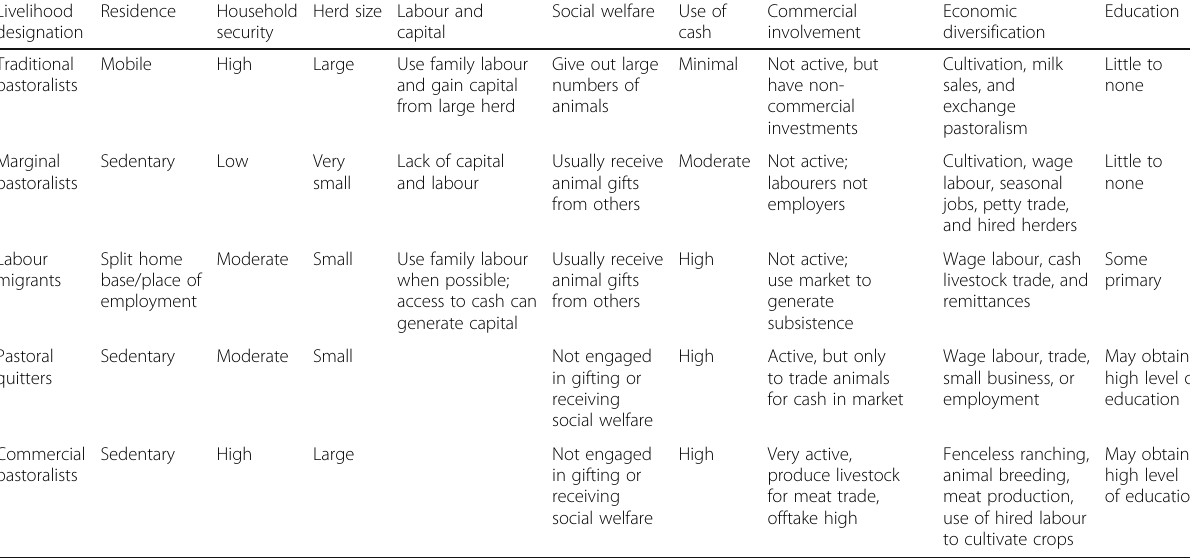
Table 1 Alternative designations of pastoral livelihood strategies and opportunities in the global age of pastoralism Livelihood designation